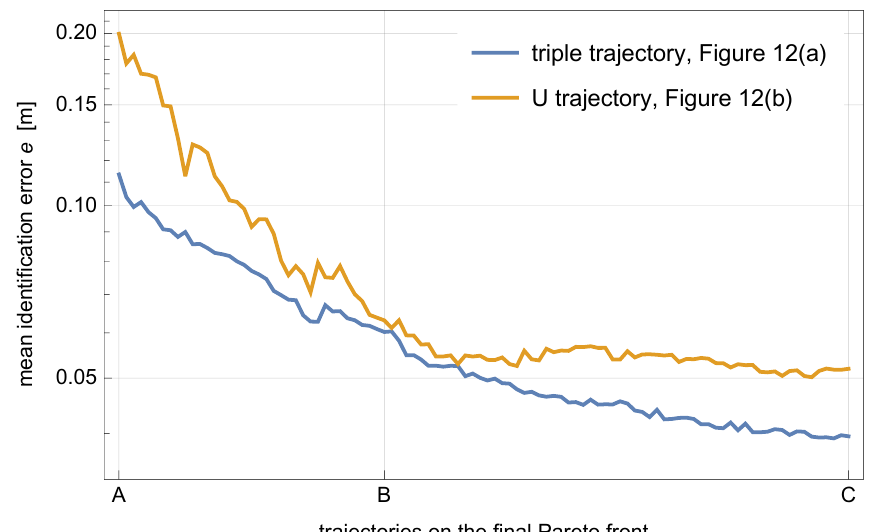
Figure 16. Mean identification error of the trajectories on the final Pareto front obtained for the compound cases shown in Figure 12. Labels “A” to “C” correspond to the labels in Figures